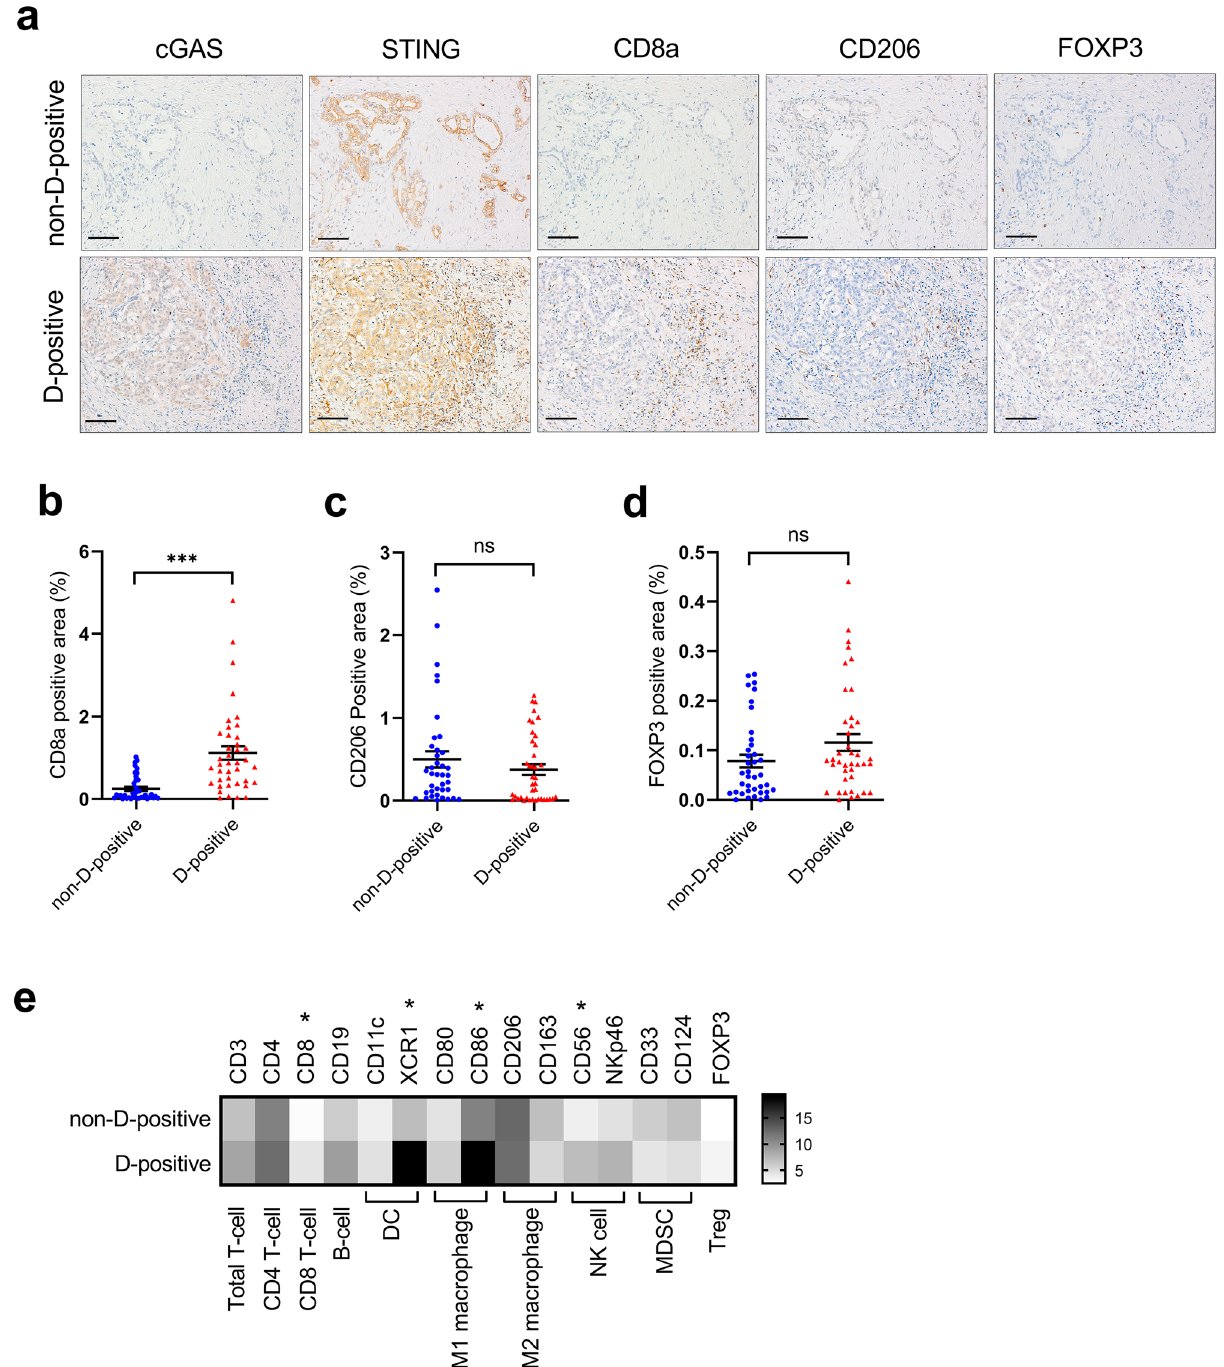
Figure 2. The infiltration of anti-tumor immune cells is enhanced in the cGAS-STING double-expressing PDAC tumors. ( a ) Immunohistochemical staining for cGAS, STING, CD8a, CD206, and FOXP3 in representative non-D-positive and D-positive cases. ( b ) The percentage of CD8a expression positive area in cGAS-STING double-positive (D-positive) tissues versus other (non-D-positive) PDAC tumors. ( c ) The percentage of CD206 expression positive area in cGAS-STING double-positive (D-positive) tissues versus other (non-D-positive) PDAC tumors. ( d ) The percentage of FOXP3 expression positive area in cGAS-STING double- positive (D-positive) tissues versus other (non-D-positive) PDAC tumors. ( e ) RT-qPCR analysis of immune cell markers in 17 FFPE PDAC tissues. Heat map showing the fold increase (versus the lowest value of each gene). Scale bar: 100 µm. Each positive area in the immunohistochemical staining was assessed by morphometry from 3 random microscopic fields (10 × objective). *** p < 0.001. ns non-significant. Statistical significance was determined using the 2-tailed t test. This figure was created using GraphPad Prism 9.3.0 (https:// www. graph pad. com/ scien tific- softw are/